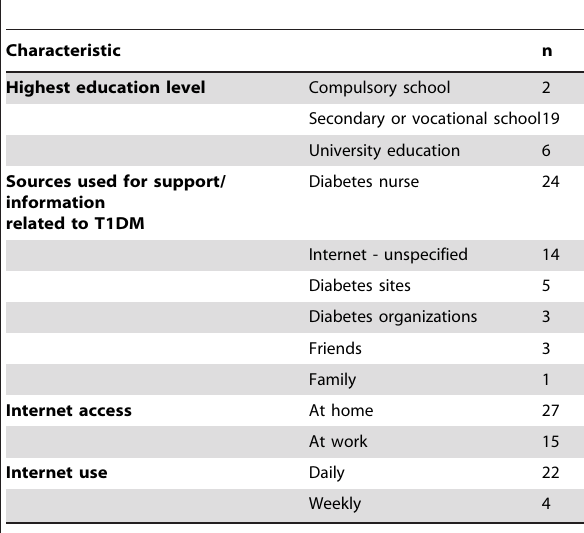
Table 1. Characteristics of the participants as self-reported on a data sheet (N